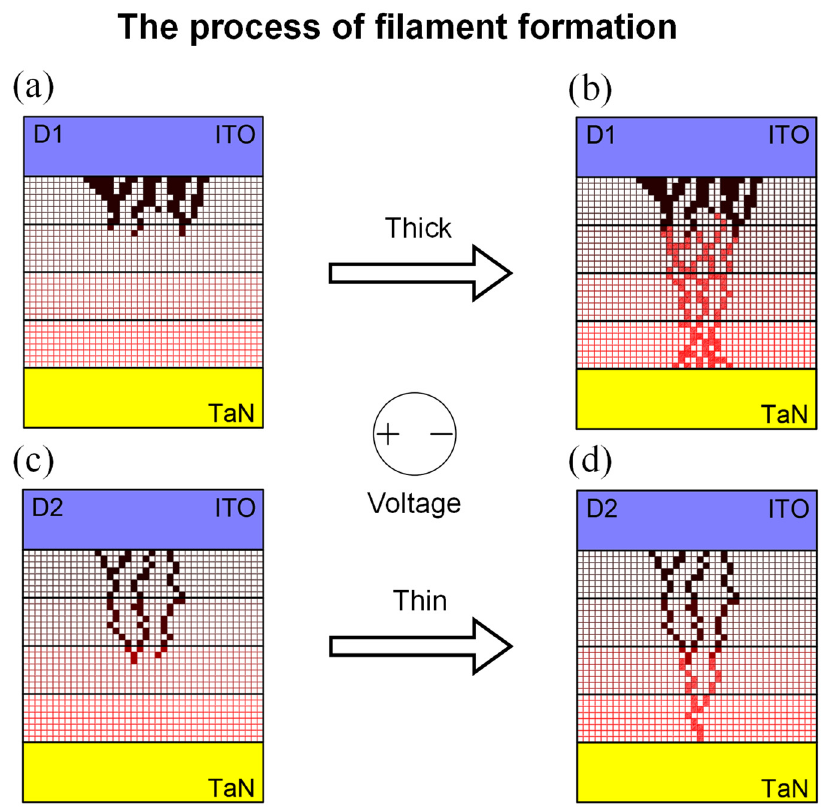
Figure 5. The formation process filaments are modeled on the XPS depth data. ( a ) Pristine state of D1. ( b ) After providing the forming voltage on D1. ( c ) Pristine state of D2. ( d ) After providing the forming voltage on D2. Dark red dots are oxygen vacancies located before electrical stimulation, while bright red dots are oxygen vacancies formed after providing forming voltage.